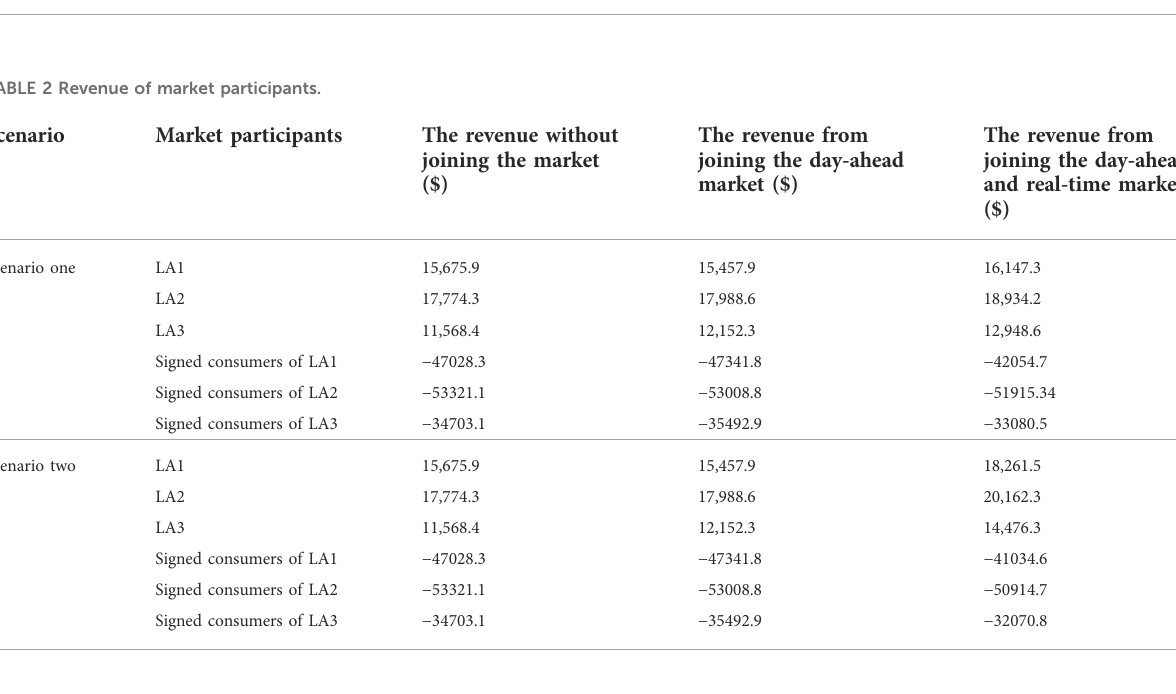
TABLE 2 Revenue of market participants.